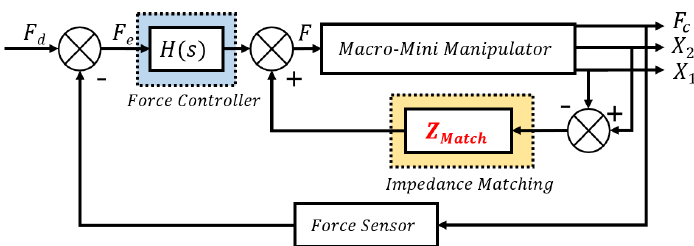
Figure 4. Block diagram of direct force control with impedance matching.